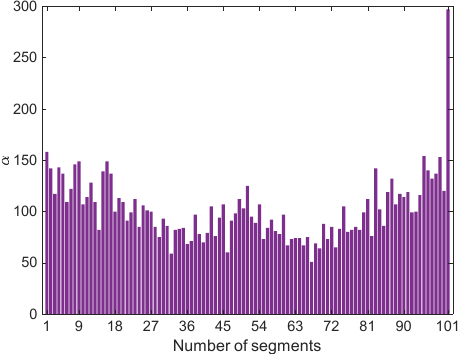
Figure 4. Exemplary segmentation of x 5 .